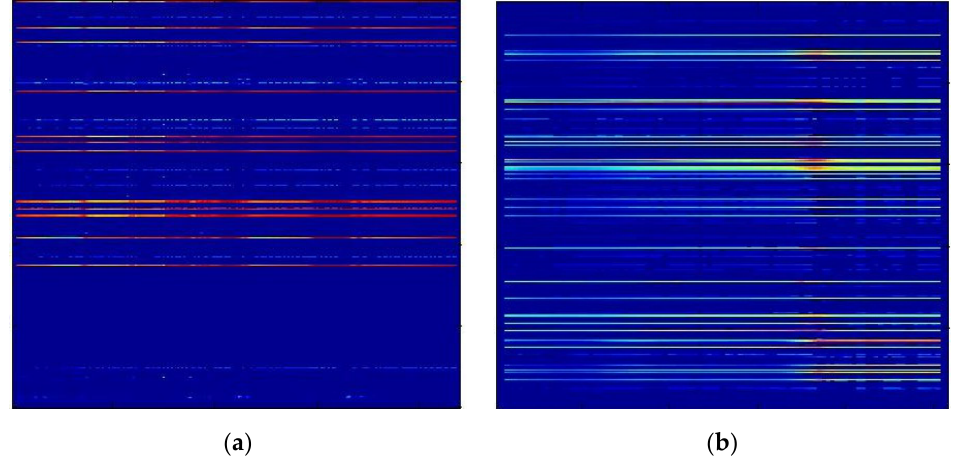
Figure 6. Patterns of: ( a ) Indian Pines and ( b ) Pavia University.